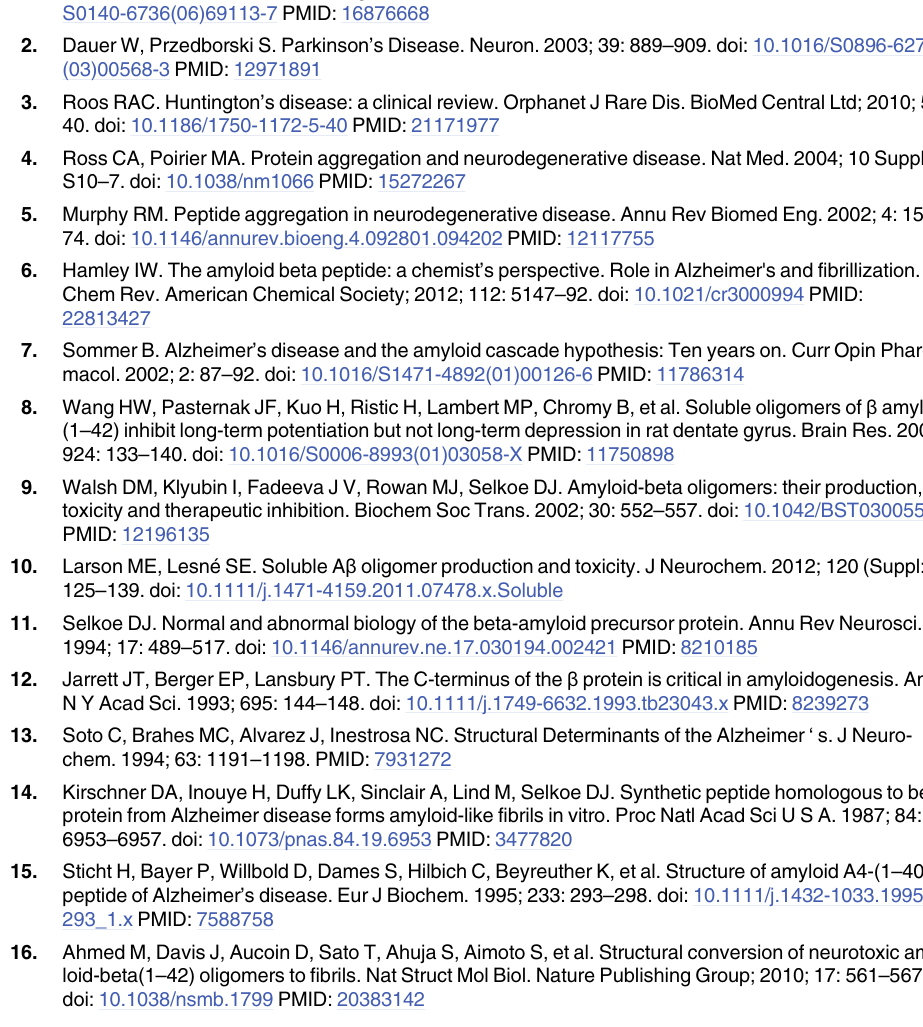
S3 Fig. Simulated scattering intensities for configurations according to PDB structures of A β and A β . Black and green lines take only the contrast to the dHFIP solvent into 1 – 42 1 – 40 account, while for red and blue lines additionally a solvent surface layer with 0.3 nm thickness and 5% higher density compared to bulk dHFIP is used. The given radius of gyration R average of the different structures in the PDB file as evaluated from the scattering in the Gui- nier region. The differences in the forward scattering for the same protein arise due to the changed protein volume if the configuration is